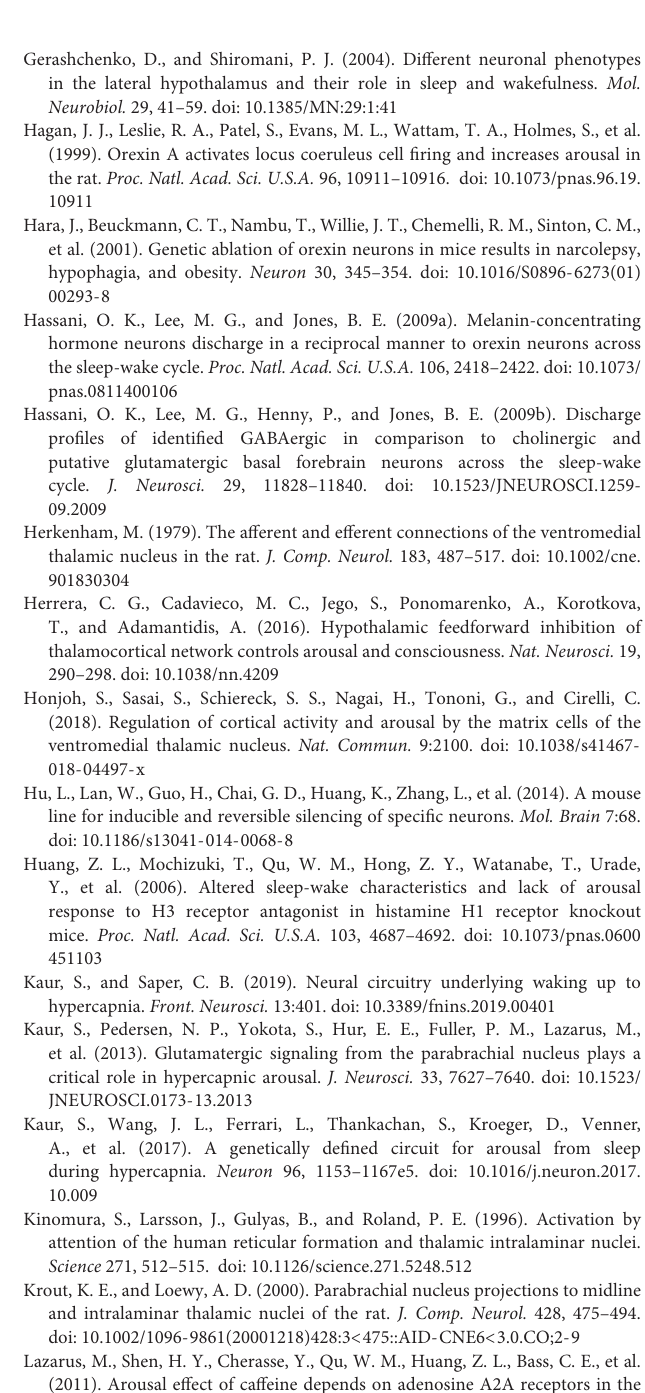
Supplementary Movie 2 | A MPB-hM3Dq rat whose behaviors were captured after the saline injection. EEG and EMG recordings, and a video show that the rat spent more time in quiet wake, and sleep, and little time in grooming, exploring, eating and drinking during the first hour, followed by more sleep during the subsequent hours after saline